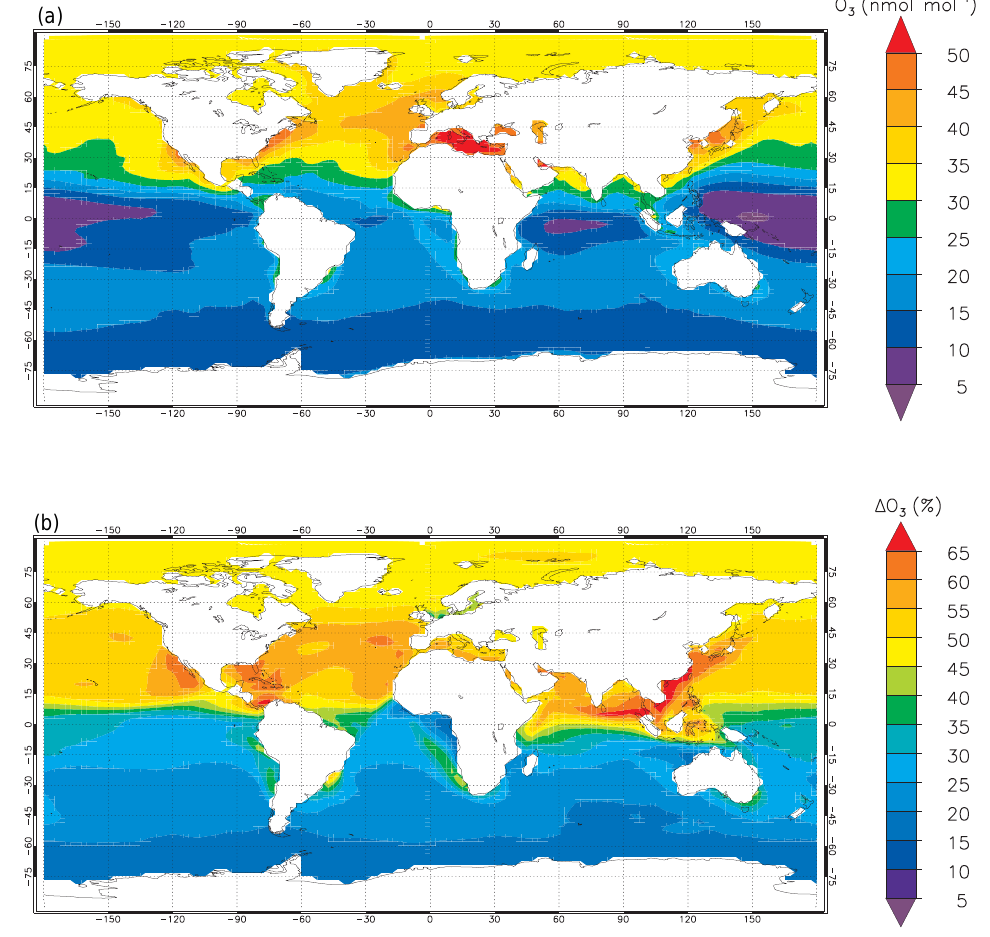
Figure 3. Modelled surface ozone in the marine environment: (a) present-day surface O 3 mixing ratio; (b) relative change of surface O 3 mixing ratio since pre-industrial times. As a result of the hemispheric gradient on the emissions of ozone precursors (Myhre et al., 2013), the increased ozone load in the Northern Hemisphere has doubled that of the Southern